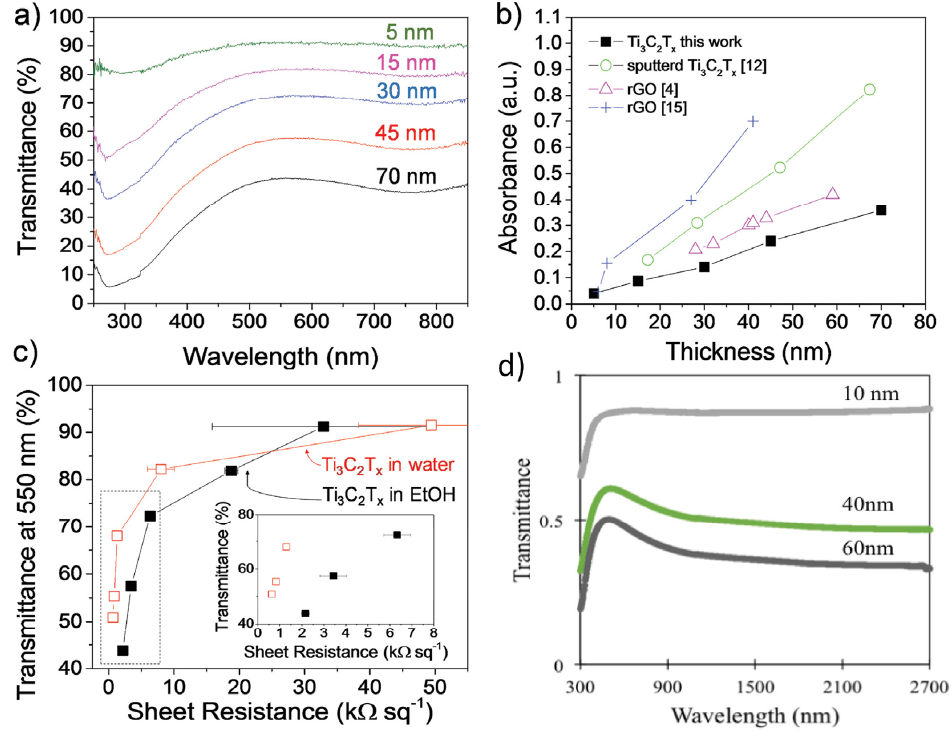
Figure 4. ( a ) UV–visible spectra of Ti 3 C 2 T x films with various thicknesses, ( b ) Effect of thickness on the absorbance of Ti 3 C 2 T x films likened with other materials, ( c ) Sheet resistance against transmittance at 550 nm of Ti 3 C 2 T x sprayed from ethanol and water solutions and ( d ) UV–vis–NIR transmittance spectra of spin cast V 2 CT x films as a function of 13 h from 10 nm to 60 nm. Reprinted with permission from [66,67].